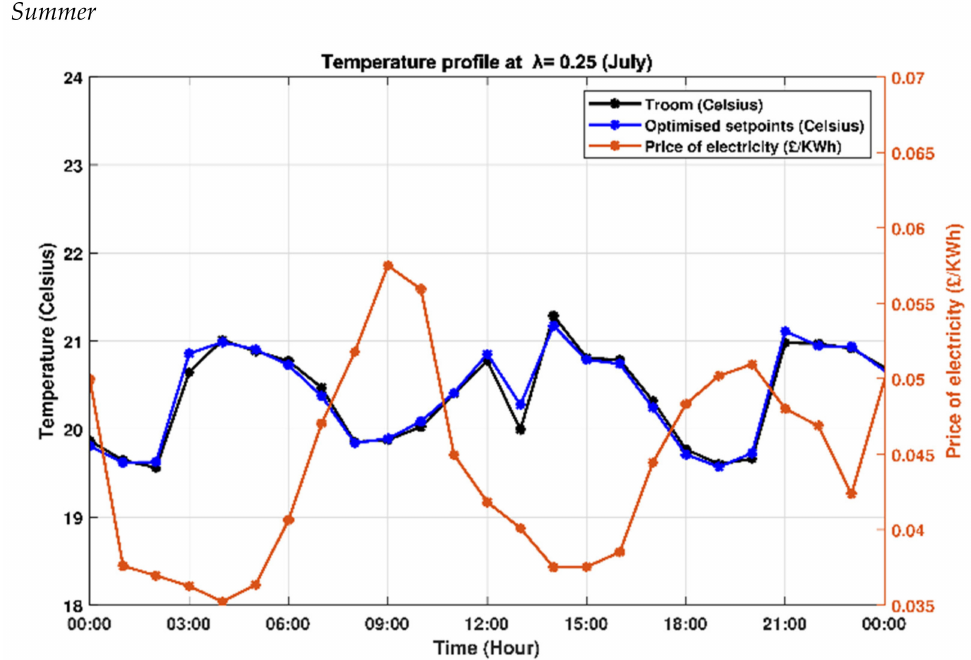
Figure 10. Room temperature and MPC-generated setpoints over 24 h using sample summer season price data.